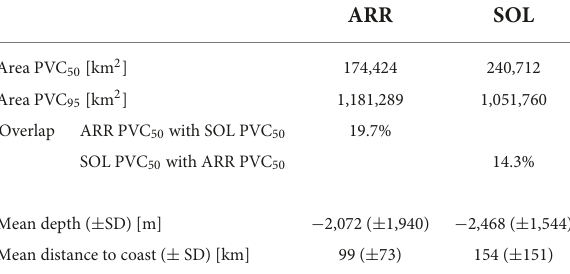
TABLE 1 Comparison of UDs (PVC 50 and PVC 95 ) within the ETP between arribada and solitary olive ridley